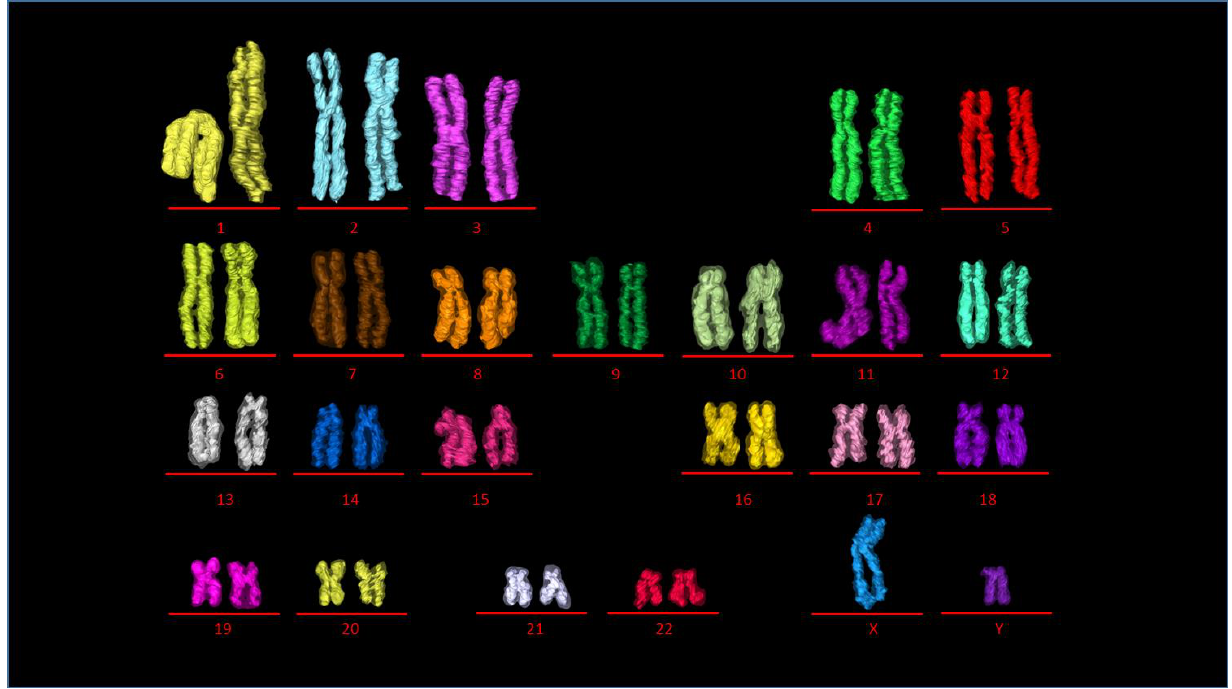
Figure 5. 3D karyotype. 3D pseudocolored karyotype displaying 23 chromosome pairs 1–22 (autosomes), X, Y (sex chromosomes). Transparent outline is the medium segmentation and inner color is from the narrow segmented data.